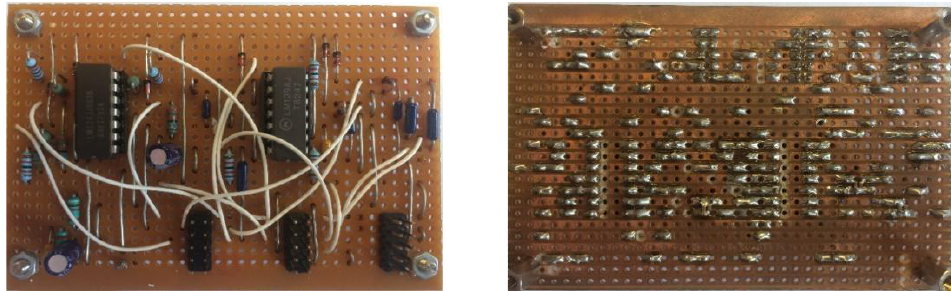
Figure 11. Front ( right ) and back view ( left ) of the completed line interface board.